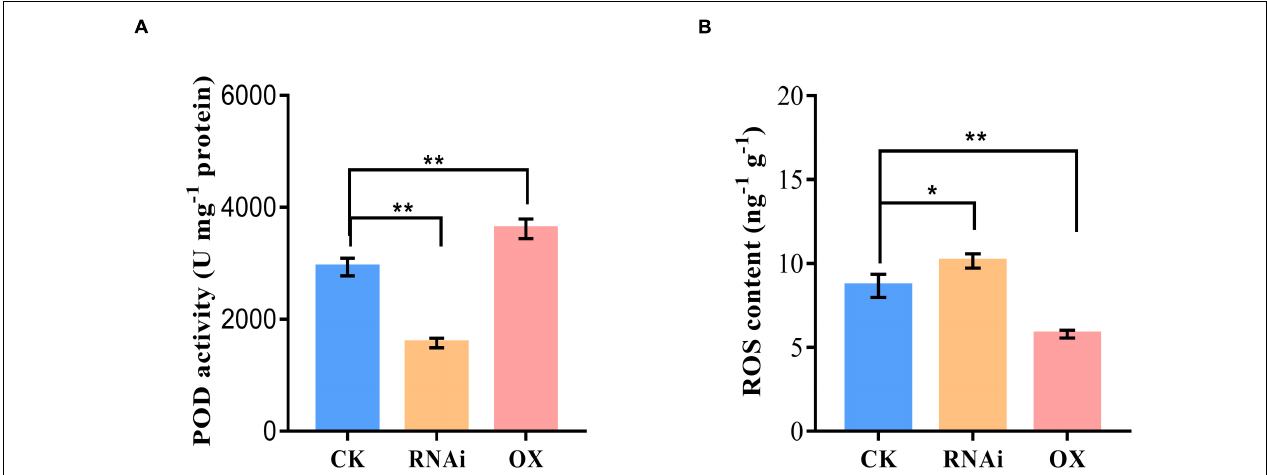
FIGURE 8 | Peroxidase (POD) activity and reactive oxygen species (ROS) content measurement in nodule of GmHSP17.1 OX and RNAi lines. (A) POD activity determination. (B) ROS content determination. Asterisks indicate statistically significant differences according to Student’s t -test (two-tailed) (* p < 0.05; ** p < 0.01), all experiments were repeated at least three